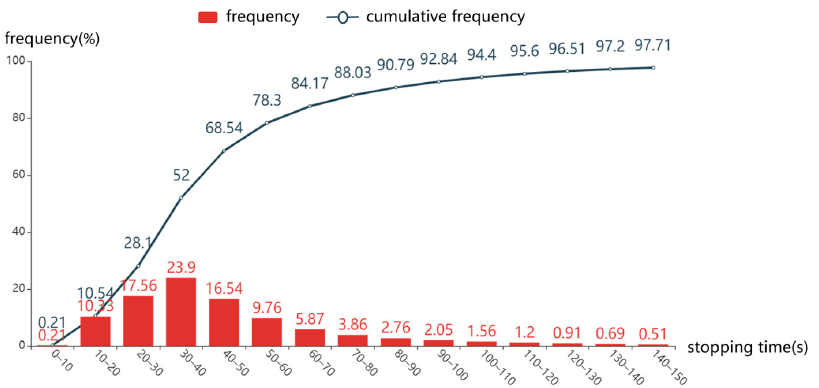
Figure 8. Frequency distribution and cumulative frequency of bus stopping time.